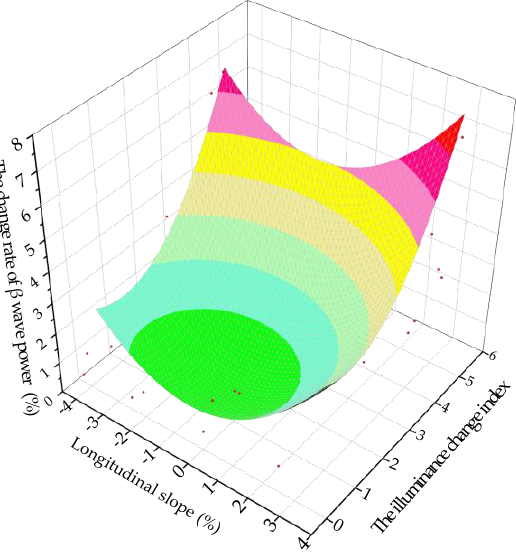
Figure 10. Fitting surface of P β under the coupling effect of illuminance and longitudinal slope.